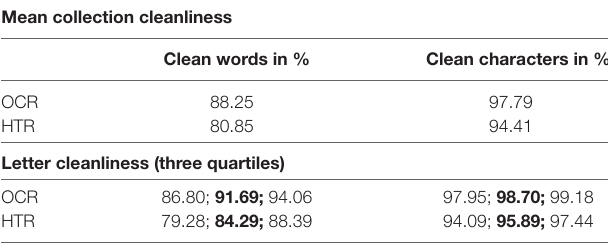
Table 5 | Cleanliness of the collection of 72 letters.